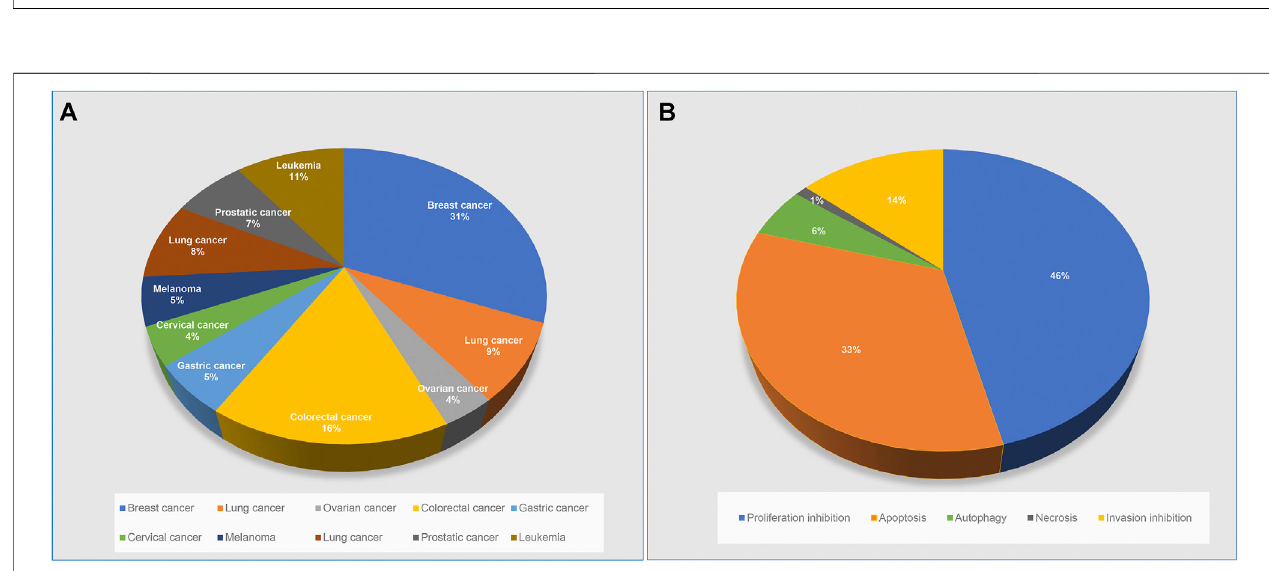
FIGURE 2 | Classi fi cation of compounds in the ACNPD. (A) Classi fi ed by cancer types: 521 compounds derived from natural products were involved in 10 cancer types and percentages, including: Breast, cervical, ovarian, lung, gastric, liver, colorectal, prostate, leukemia and melanoma. (B) Classi fi ed by pharmacological mechanisms: all compounds are classi fi ed into fi ve groups according to text retrieval: proliferation inhibition, apoptosis, autophagy, necrosis, invasion inhibition. Note: Groups are marked with different colors. The percentage of compounds contained in each group is shown in the pie chart.